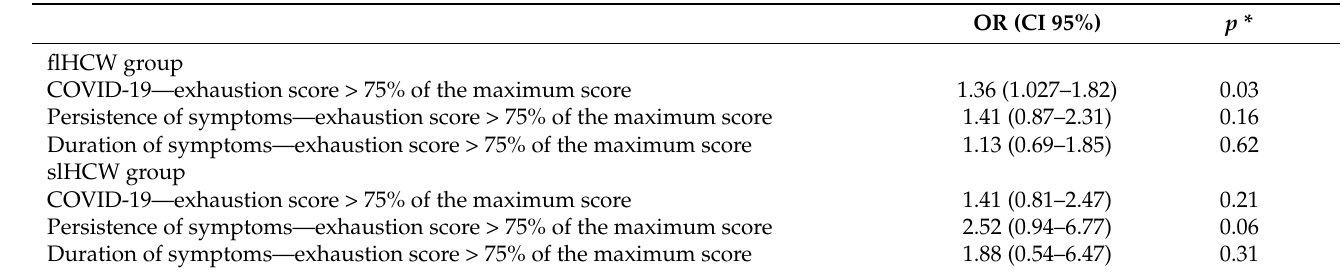
Table 8. Relation between the high exhaustion scores and the diagnosis of COVID-19 of the HCW in the frontline and the second-line healthcare